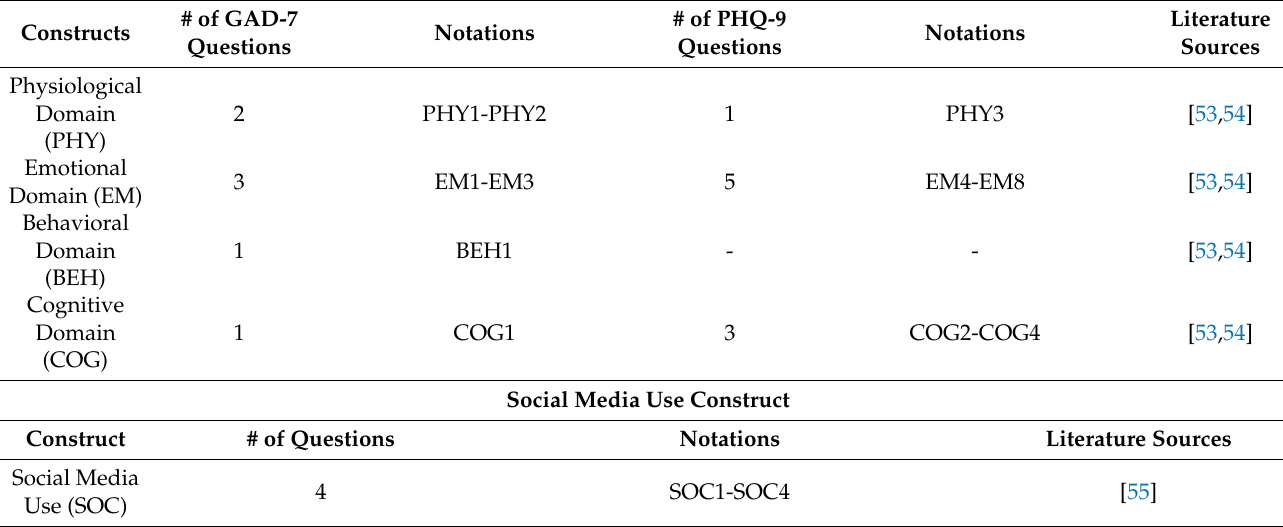
Table 1. Measurement